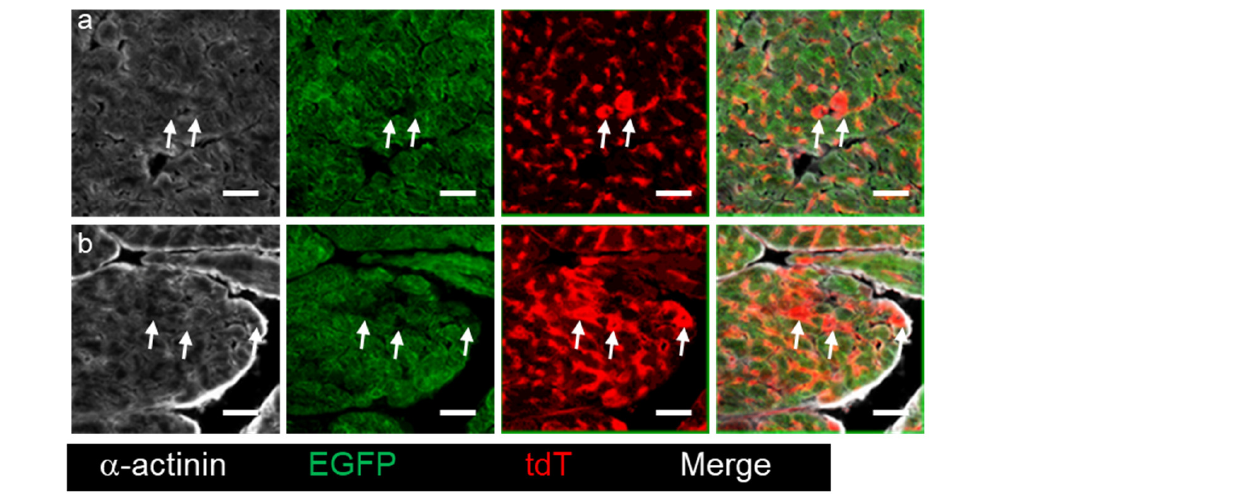
Figure 7. Concerted expression and action of Wisper and NOTCH1 signaling on cardiac fibrosis and new myocyte formation. ( A ) Experimental protocol. Tamoxifen-treated (5 consecutive days) Myh6-MerCreMer;ROSA26-mTmG reporter mice were subjected to transaortic constriction or Sham operation and 2 and 9 days post-surgery, they received Wisper-GapmeR or Control (Cont.)-GapmeR. Two weeks after TAC, they were treated twice with α NRR1 antibody at 4 days interval or left untreated (None). The hearts were harvested 4 weeks after TAC and analyzed. ( B ) Masson Trichrome of heart tissue sections showing collagen deposition (blue). ( C ) Quantitative analysis of cardiac fibrosis expressed as percent of whole-heart sectional area. ( D , E ) Wisper knockdown stimulates formation of new CMs. ( D ) Fluorescence photomicrograph of a whole heart section showing tdT+ CMs in the endocardium and myocardium regions. The areas within squares are displayed at higher magnifications demonstrating the presence of α -actinin+ (gray), tdT+ CMs (red) in the endocardium ( a ) and myocardium ( b ) in contact with pre-existing EGFP+ CMs (green). ( E ) Quantification of new tdT+ CM formation expressed as percent of total number of CMs per whole heart tissue section. The graphs in ( E ) show mean ± SEM. *, p < 0.05 in TAC vs. Sham; †, p < 0.05 in Wisper-GapmeR vs. Control-GapmeR; ‡, p < 0.05 in α NRR1 vs. None and n.s., not significant (Sham Control-GapmeR α NRR1, n = 3; Sham Wisper-GapmeR α NRR1, n = 3; TAC Control-GapmeR α NRR1, n = 5;